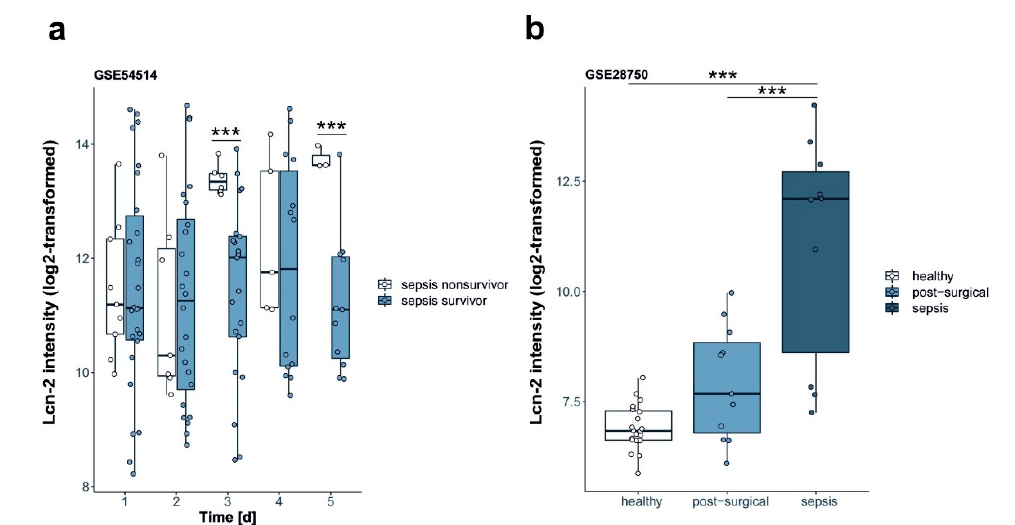
Figure 6. Patient data. Analysis of Lcn-2 expression in the blood of septic patients from publicly available datasets. Data are presented as box- and whisker plots of Lcn-2 expression in the serum. White and gray rectangles represent interquartile range, line in the middle of each rectangle represents the median value. Lines extending from the interquartile range mark the 5th and 95th percentile values, and the individual open circles represent values of each single patient. Analysis of ( a ) Lcn-2 expression in the whole blood transcriptome of survivors and non-survivors of sepsis from Parnell et al. (GSE54514) [22]. ( b ) Lcn-2 expression in PAXgene blood collected for leucocyte RNA isolation and gene expression analysis) from Sutherland et al. (GSE28750) [23]. *** p < 0.001.